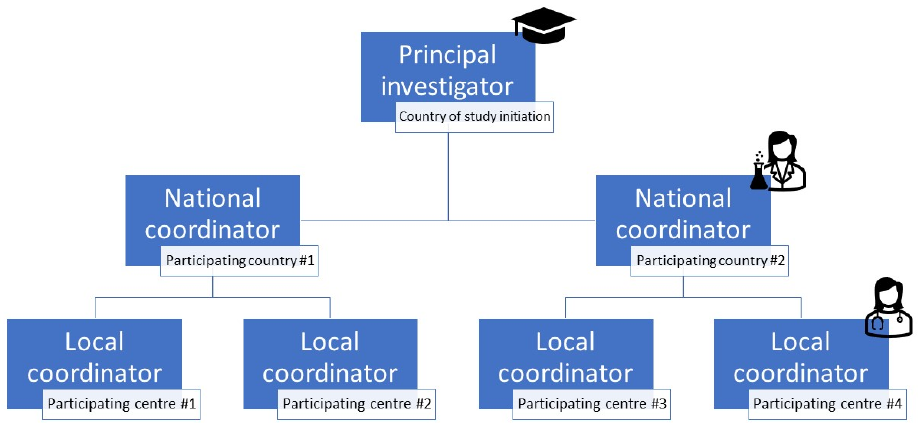
Figure 1. Example of a hierarchical study structure for a study in two countries with two participat- ing centres each. centres